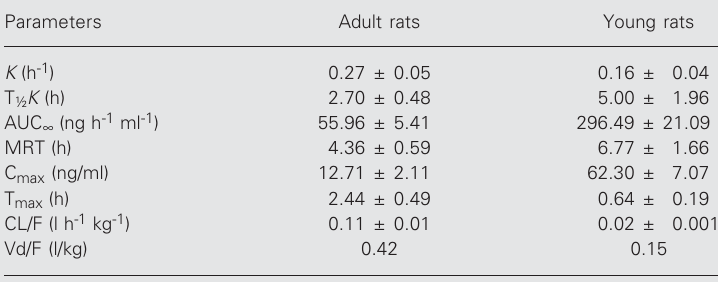
Table 1. Pharmacokinetic parameters of subcutaneous injection of 6 µg 99m